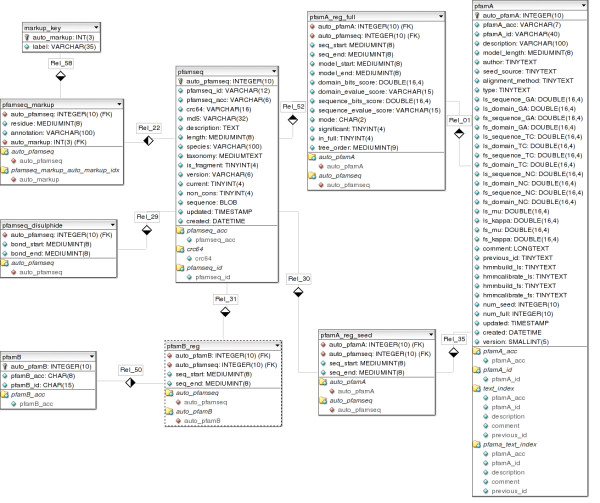
Database entities diagram showing the active site tables (pfamseq_markup and markup_key) in relation to other key tables in the Pfam database. The 'pfamseq' table is one of the central tables in Pfam and contains the sequence information. The Pfam-A alignments (both seed and full) and Pfam-B alignments that a particular active site residue belongs to can be accessed via the tables that link off pfamseq (pfamA_reg_full, pfamA_reg_seed, pfamA, pfamB_reg, pfamB). The red diamonds denote an indexed column and the key symbol denotes the primary key. The diamonds connecting the tables indicate many-to-one relationships with the dark filled end of the diamond indicating the many side of the relationship.